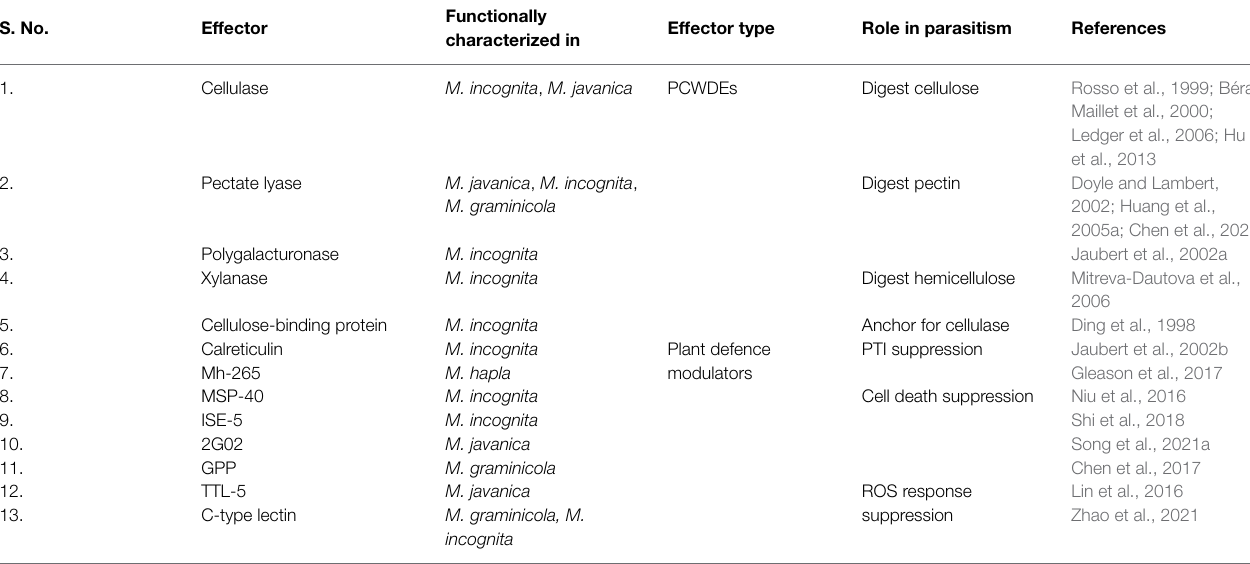
TABLE 1 | Experimentally identified effectors from the sub-ventral glands of various RKNs. S.